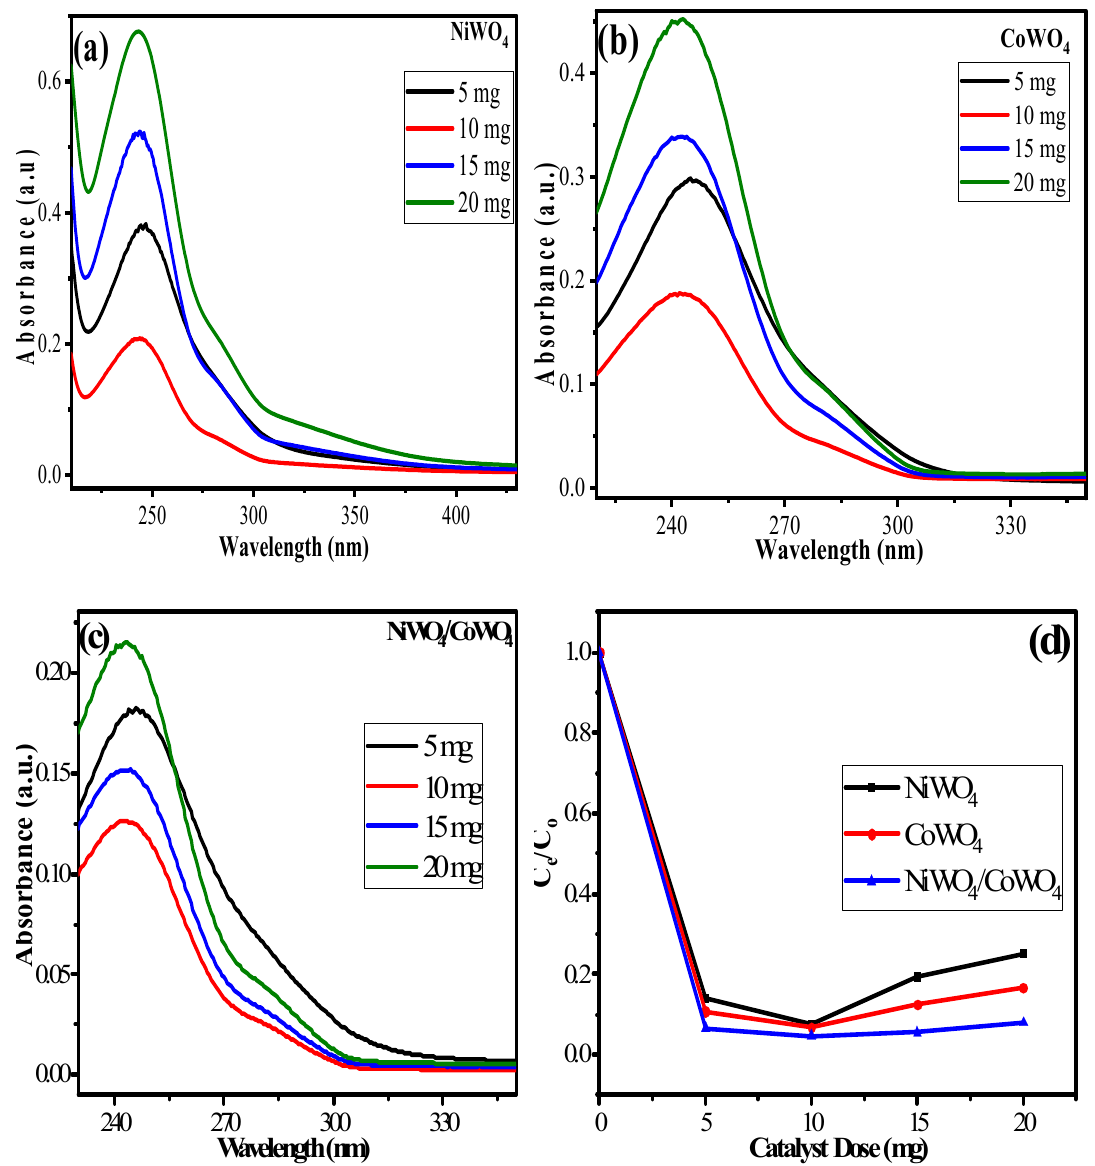
Figure 8. Effect of variable catalyst dose (5–20 mg) using 50 ppm PCT for ( a ) NiWO 4, ( b ) CoWO 4, ( c ) NiWO 4 /CoWO 4 NC, and ( d ) C e /C o vs catalyst dose plot.